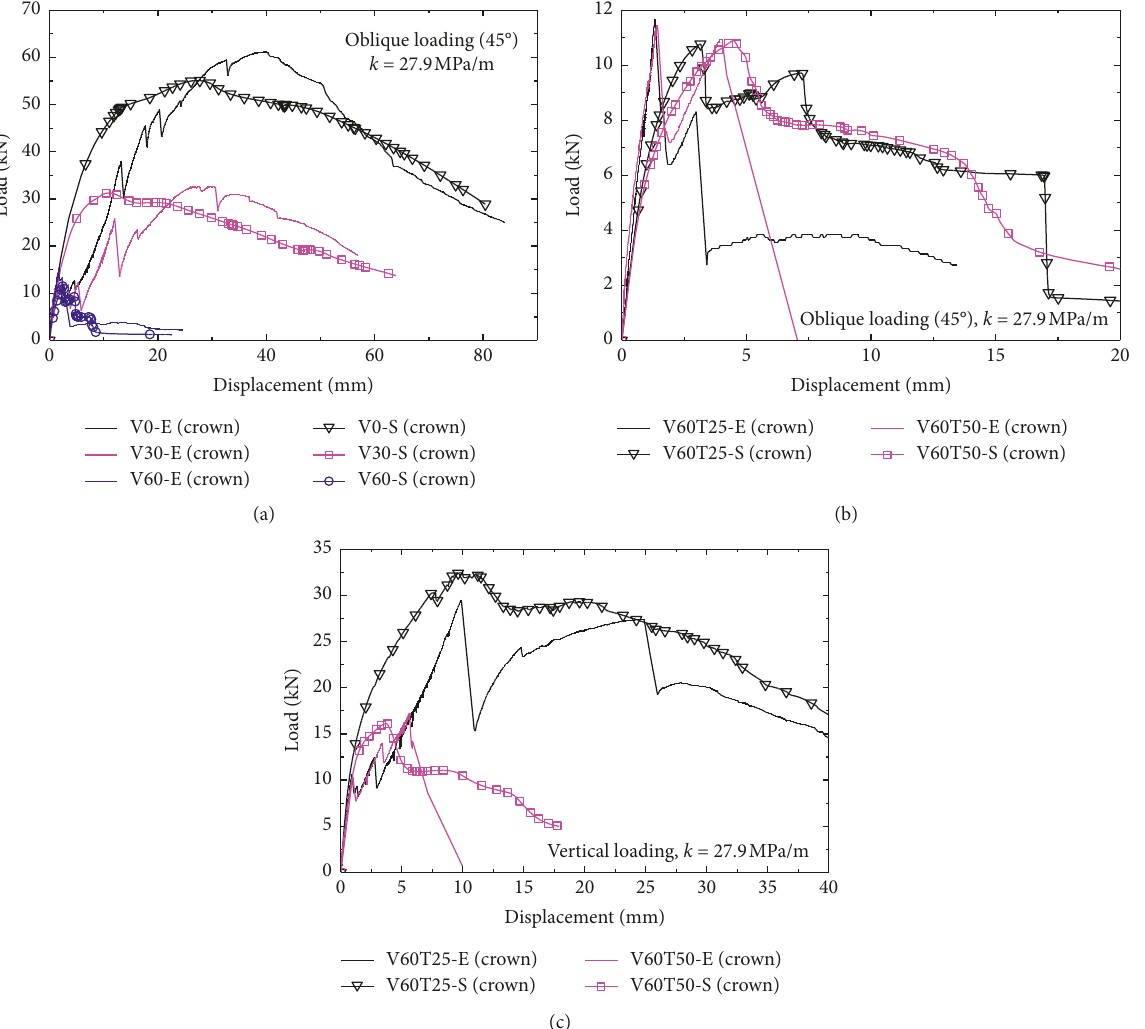
Figure 7: Comparative analysis of load-displacement curve of the lining. (a) Vault crown voids of the lining. (b) Combined vault crown voids of the lining. (c) Combined spandrel voids of the